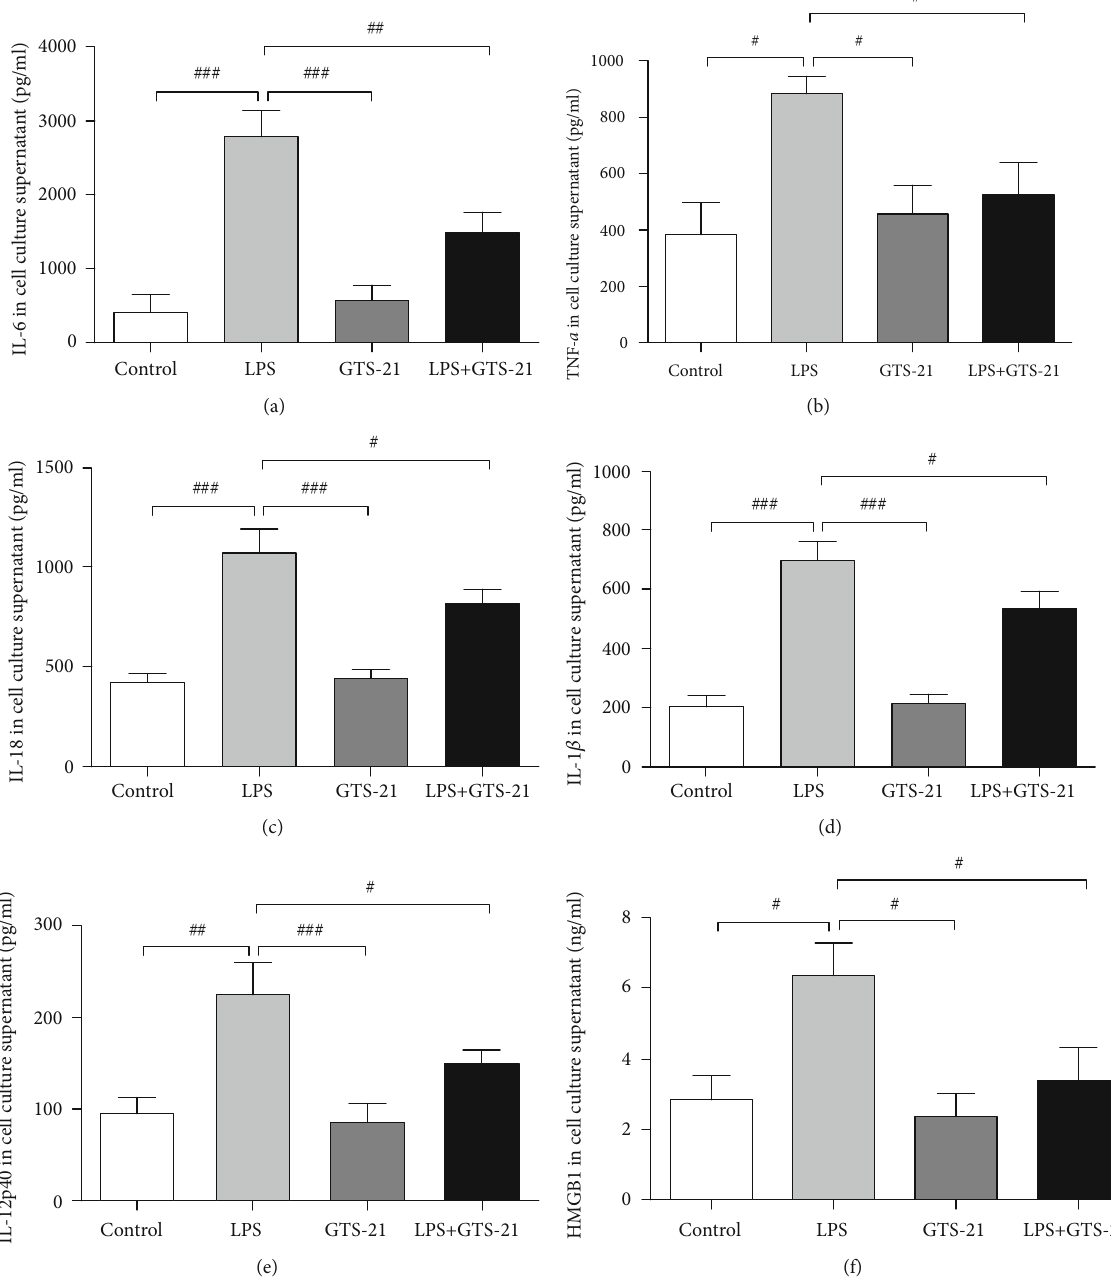
Figure 5: GTS-21 administration reduced DC-related proin fl ammatory cytokine levels in vitro . (a – d) The productions of cytokines IL-6, TNF- α , IL-18, IL-1 β , IL-12p40, and HMGB1 in BMDC culture supernatant were measured by ELISA. All data are shown as mean ± SD ( n = 4 – 6 mice/group). # p < 0 : 05 , ## p < 0 : 01 , ### p < 0 : 001